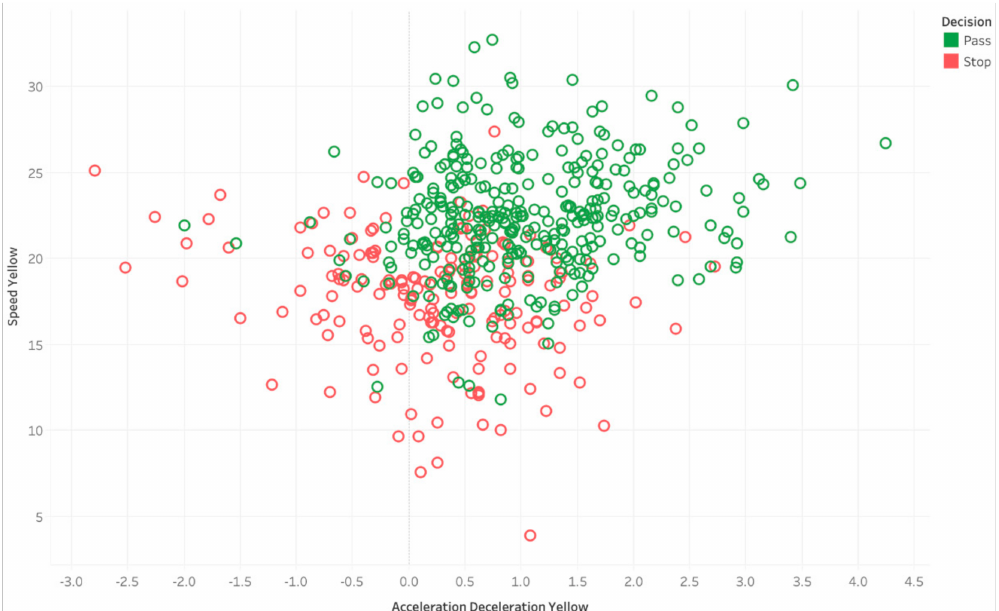
Figure 6. Correlation of driver’s decision with speed and